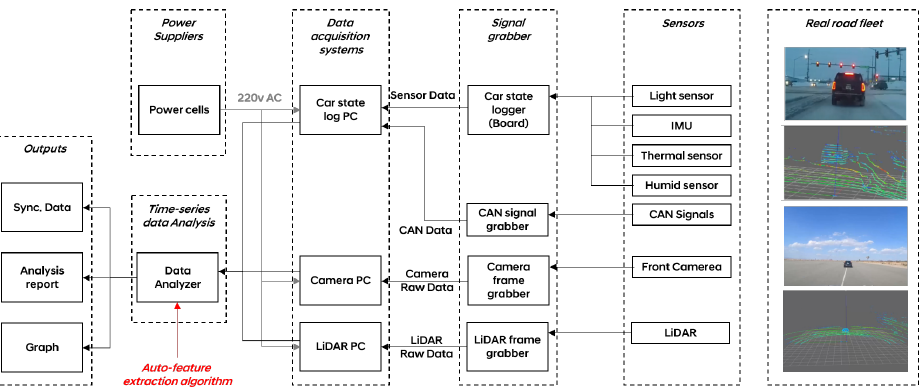
Figure 2. Schematic diagram of the test vehicle. In real road fleets, the test vehicle collects front camera images, point clouds of LiDAR sensors, and time-series signals of environments and car status. The gathered data is stored in industrial PCs installed in the luggage compartment. Additional batteries are used to supply electronic power to each